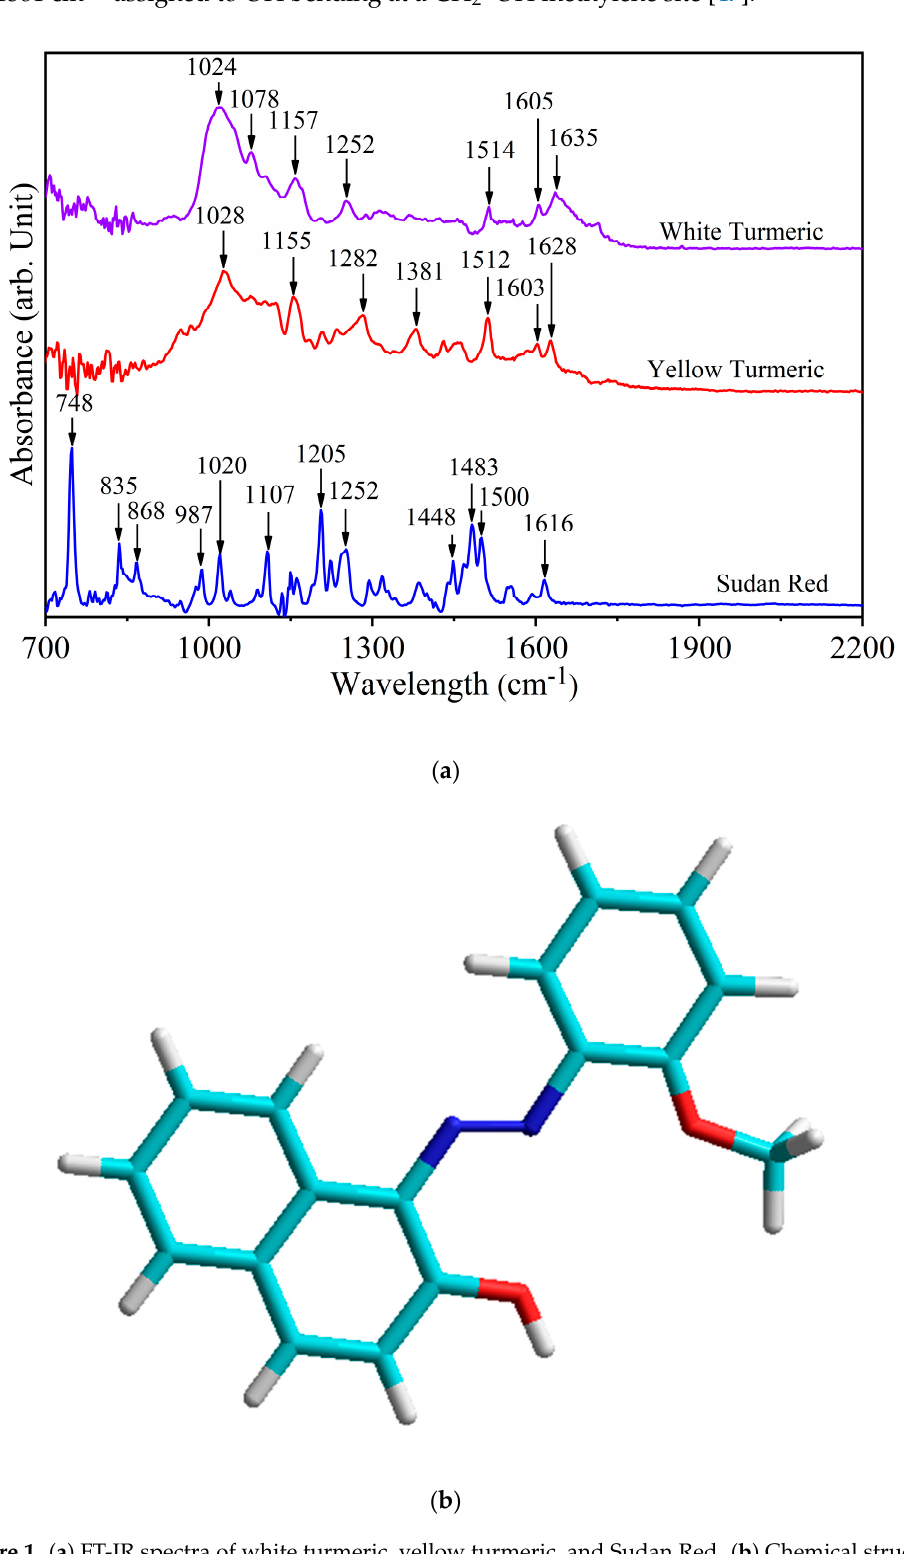
Figure 1. ( a ) FT-IR spectra of white turmeric, yellow turmeric, and Sudan Red. ( b ) Chemical structure of Sudan Red: light blue is carbon, dark blue is nitrogen, red is oxygen, and white is hydrogen.